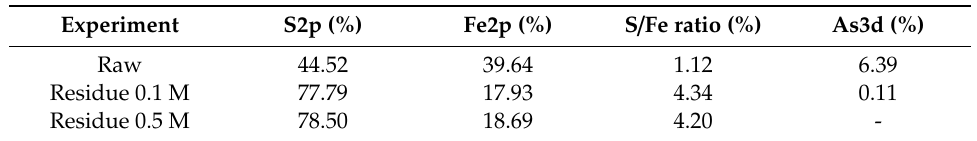
Table 2. Refractory gold concentrate and leach residue surface atomic composition with di ff erent treatments. The leaching conditions were a reaction temperature of 80 ◦ C reaction time of 15 min, and HNO 3 concentration of 0.1 and 0.5 M.